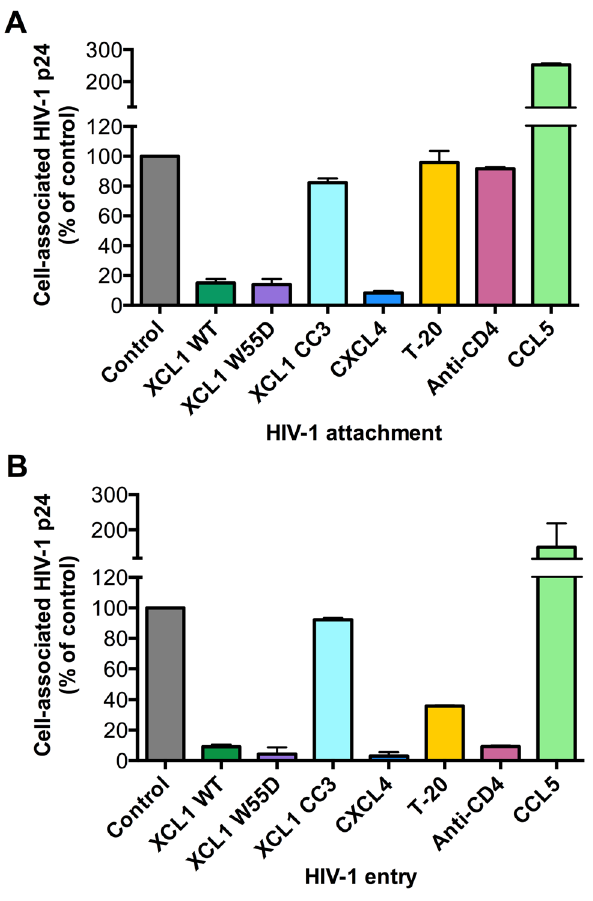
Figure 4. XCL1 blocks HIV-1 attachment and entry into target cells. Both attachment and entry assays were performed on TZM-bl cells incubated with the XCL1-sensitive dual tropic HIV-1 strain, 92HT599. (A) Virus attachment was measured as the total amount of cell-associated p24 Gag protein after 4 h incubation with virus at 37 u C and subtraction of background levels. Background attachment/entry was quantified as the cell-associated p24 Gag after incubation of cells with virus at 4 u C and subsequent trypsin treatment. (B) Virus entry assay was performed in a similar manner except cells were incubated with virus for 2 additional hours (6 h total) and trypsinized to remove extracellular-associated virus. Cells were lysed and virus entry was determined as the total amount of trypsin-resistant, intracellular p24 protein. Recombinant cytokines were used at 15 m g/mL, the T-20 fusion inhibitor at 50 m g/mL, and anti-CD4 antibody at 20 m g/mL. The data represent mean values ( 6 SD) of replicate wells from at least 3 independent experiments.